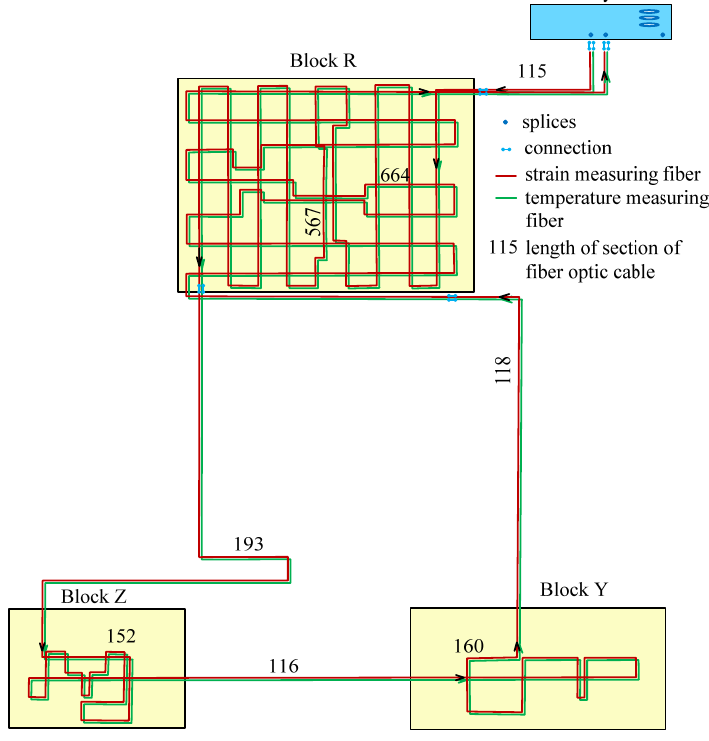
Figure 6. Schematic diagram of distributed fiber optic strain sensing system.